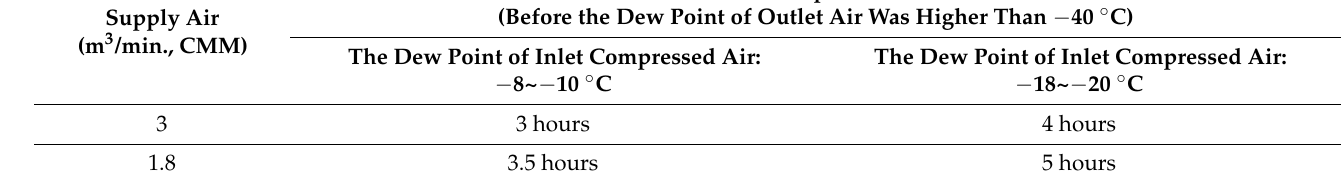
Figure 16. Temperature curves of the ETAU system. Table 5. ETAU compressed air dryer test results.